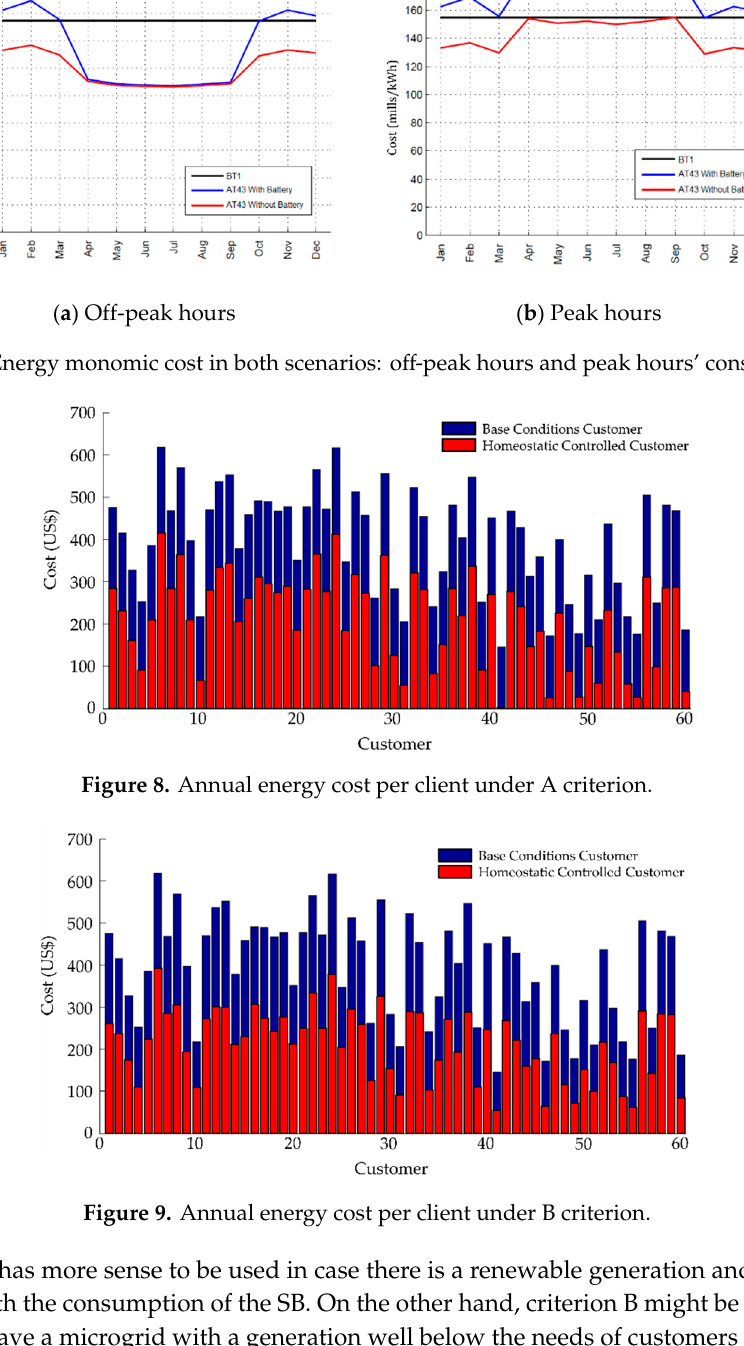
14 of 19 Figure 6. Sustainable Block Power flow with battery and hourly tariff. Internal electric tariff for microgrid customers is shown in Figure 7. As is described in Figure 6, the battery is used to supply the excess energy consumption that the microgrid cannot supply during peak hours. Internal electric tariff for microgrid customers is shown in Figure 7. This tariff, based on the monomic energy cost, is employed with the aim to achieve an efficient energy consumption and to transfer the gain in energy cost derived from the improved efficiency to the customers. Thus, it can be observed that the energy cost at peak time is considerably higher than that of non-peak hours, hence, customers are induced to adopt a more efficient and productive consumption behavior in